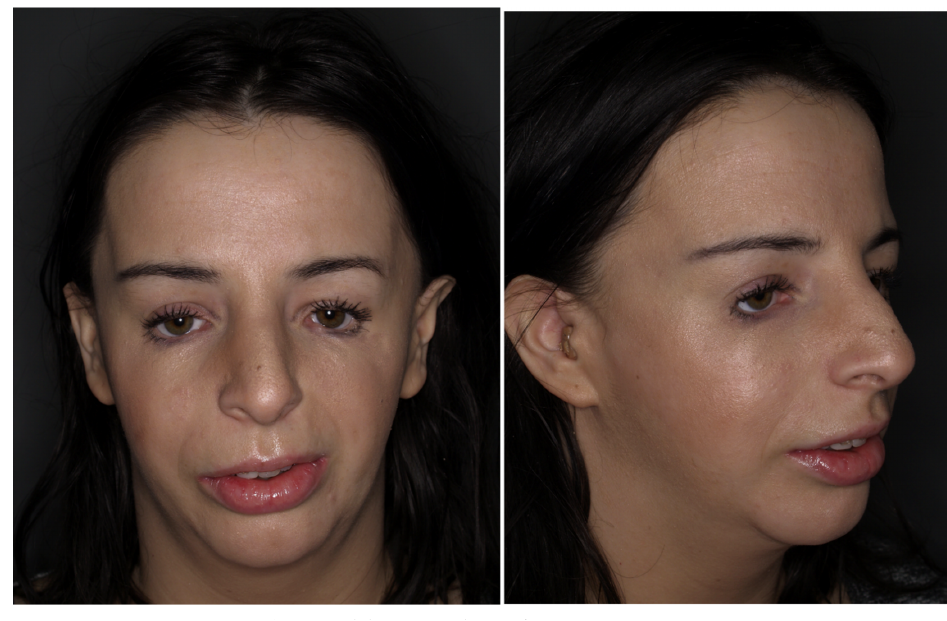
Figure 7. Adult patient with TCS after correction treatment.